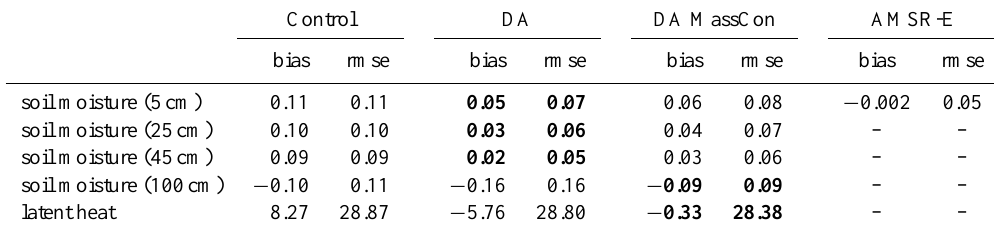
Table 3. Basin averaged bias and root mean square error (rmse) of daily simulated soil moisture at the 5, 25, 45 and 100cm depths, latent heat (Wm − 2 ) and AMSR-E soil moisture retrievals for the two-year period. Statistics were calculated with respect to daily values of ground measurements at ARS, SCAN and SGP. Numbers in bold represent the minimal bias or rmse among Control, DA and DA